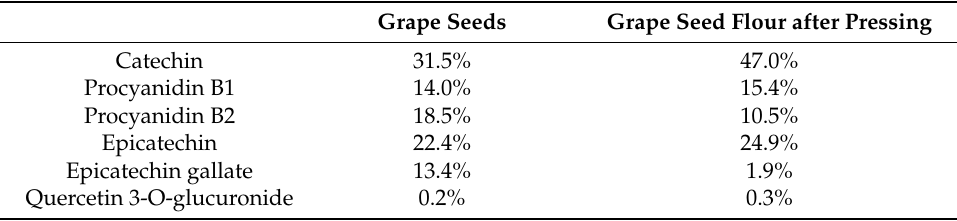
Table A2. Percentage composition of polyphenols in grape seeds and pomace